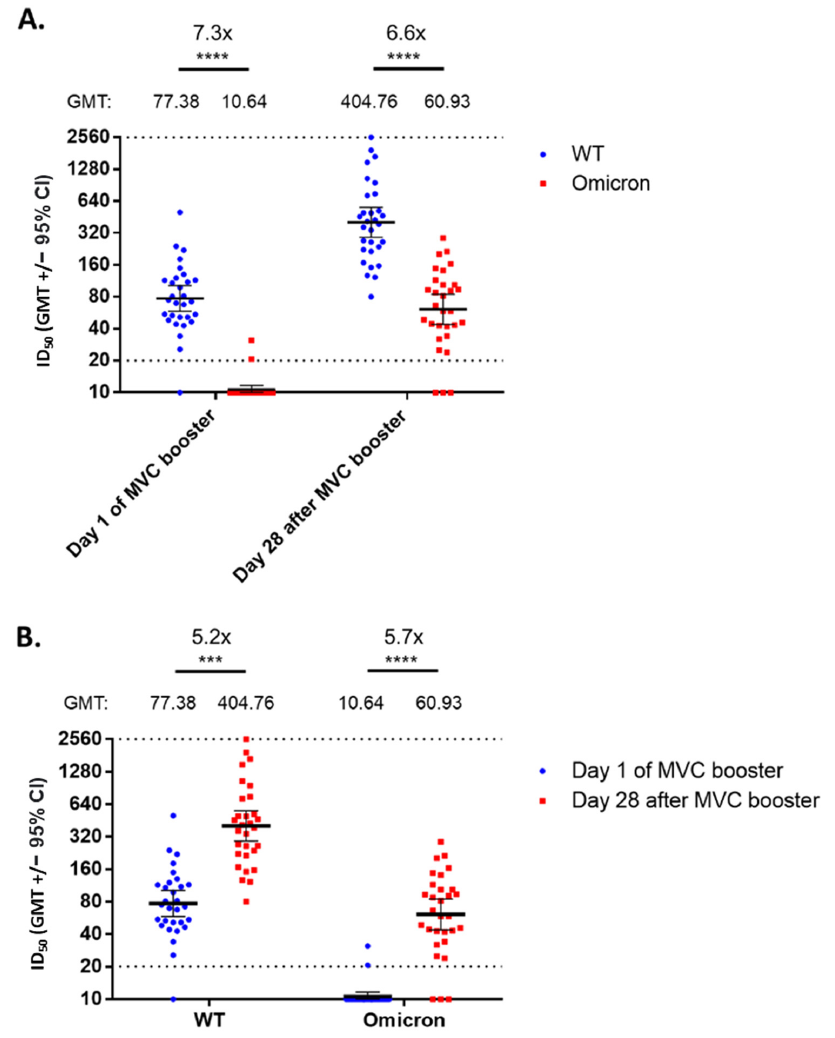
Figure 4. Neutralizing assay against ancestral strain and Omicron variant pseudoviruses. Serum samples on the day of the MVC booster dose and day 28 after the MVC booster dose from 30 ran- domly selected individuals of the immunogenicity analysis subset from group A (i.e., MVC − COV1901 booster administered within 12 weeks from the last AZD1222 dose) were taken. ( A ) grouped according to the time of sampling; ( B ) grouped according to pseudovirus type. The results were presented by horizontal bars representing geometric mean titer with error bars for 95% confi- dence interval values. Statistical significance was calculated with the Kruskal-Wallis test with cor- rected Dunn’s multiple comparisons test. *** = p < 0.001, **** = p < 0.0001. 4. Discussion The antibody quantifications presented here demonstrate that following a waning period post second immunization with AZD1222, a booster shot with MVC-COV19 sig- nificantly raises binding antibody levels by as much as 14-fold. More importantly, the maximum antibody levels achieved with the booster exceed those achieved by two im- munizations with AZD1222. Similar results have been observed in an extension of the MVC-COV1901 phase 1 trial that followed the same observation and vaccination time points as this study but used MVC-COV1901 for all three immunizations [14,15].